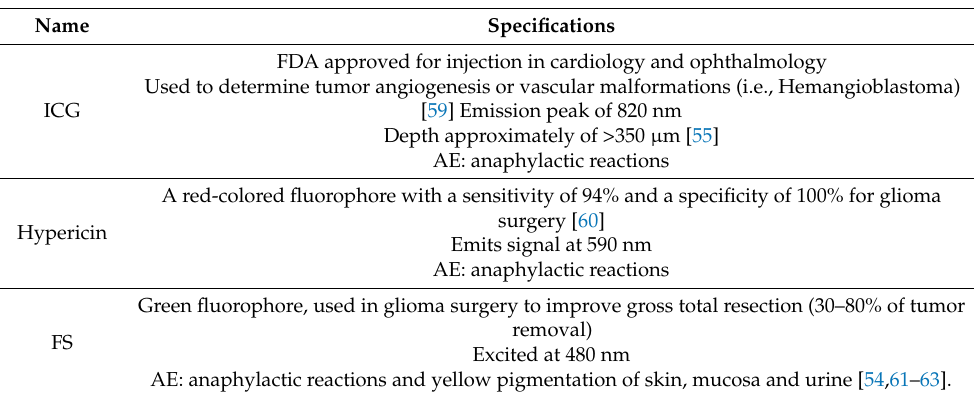
Table 2. Extrinsic fluorescent contrast